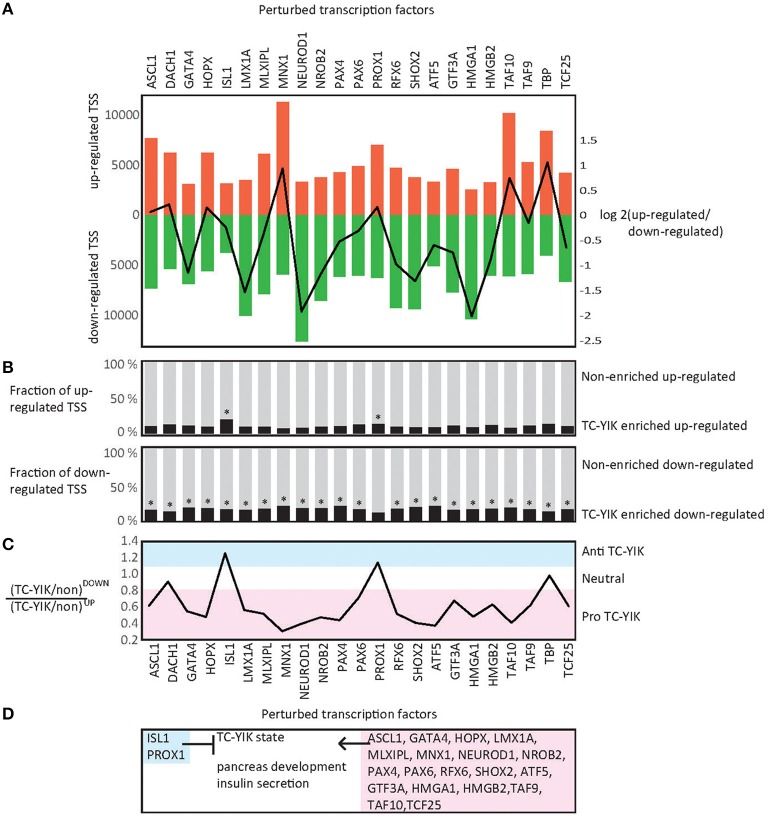
KD-CAGE analysis. (A) Up-regulated and down-regulated TSSs in KD-CAGE experiments. Bars indicate, the numbers of up-regulated, and down-regulated TSSs detected by edgeR (p < 0.05) after siRNA knockdown of each factor. Line indicates the log transformed ratio of up-regulated to down-regulated TSS (e.g., note NEUROD1 causes a much larger number of down-regulated TSS than up-regulated ones, while MNX1 shows the reverse). (B) Fractions of up or down-regulated promoters that are TC-YIK-enriched or non-enriched. (C) Comparison of the ratios of TC-YIK-enriched to non-enriched promoters for up and down-regulated TSS sets. Note, ISL1 and PROX1 appear antagonistic to the TC-YIK state. (D) Diagram summarizing the results of the state enrichment and gene ontology enrichment analyses. *Indicates at least 15% of the up or down-regulated promoters were TC-YIK enriched.